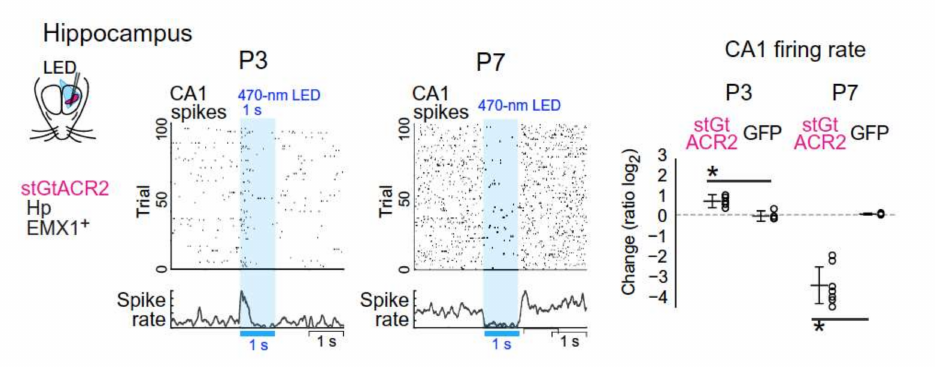
Figure 2. GABA excites pyramidal neurons in vivo in unanesthetized rodents. Changing the role of anion conductance by photostimulation of channelrhodopsin virally expressed in the soma of non-GABAergic neurons generates different effects at P3 and P7. This stimulation increased the firing rate at P3 and reduced it at P7. With permission From